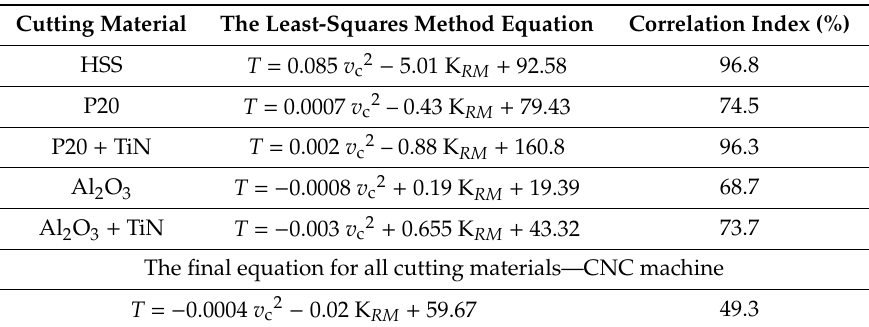
Table 10. T-v c equations for CNC